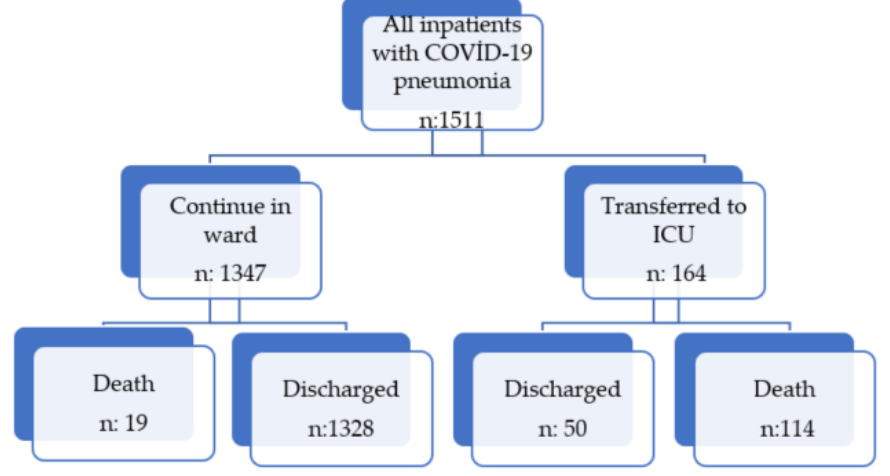
Figure 1. Flow chart of study population.